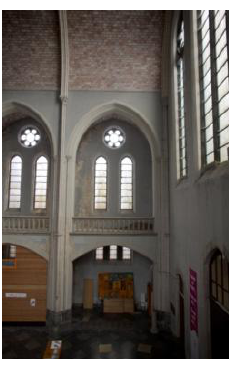
Figure 7: The HDR image created by the sequence of Figure 6 Figure 8: Orthophotomosaics made by (a) normal and (b)